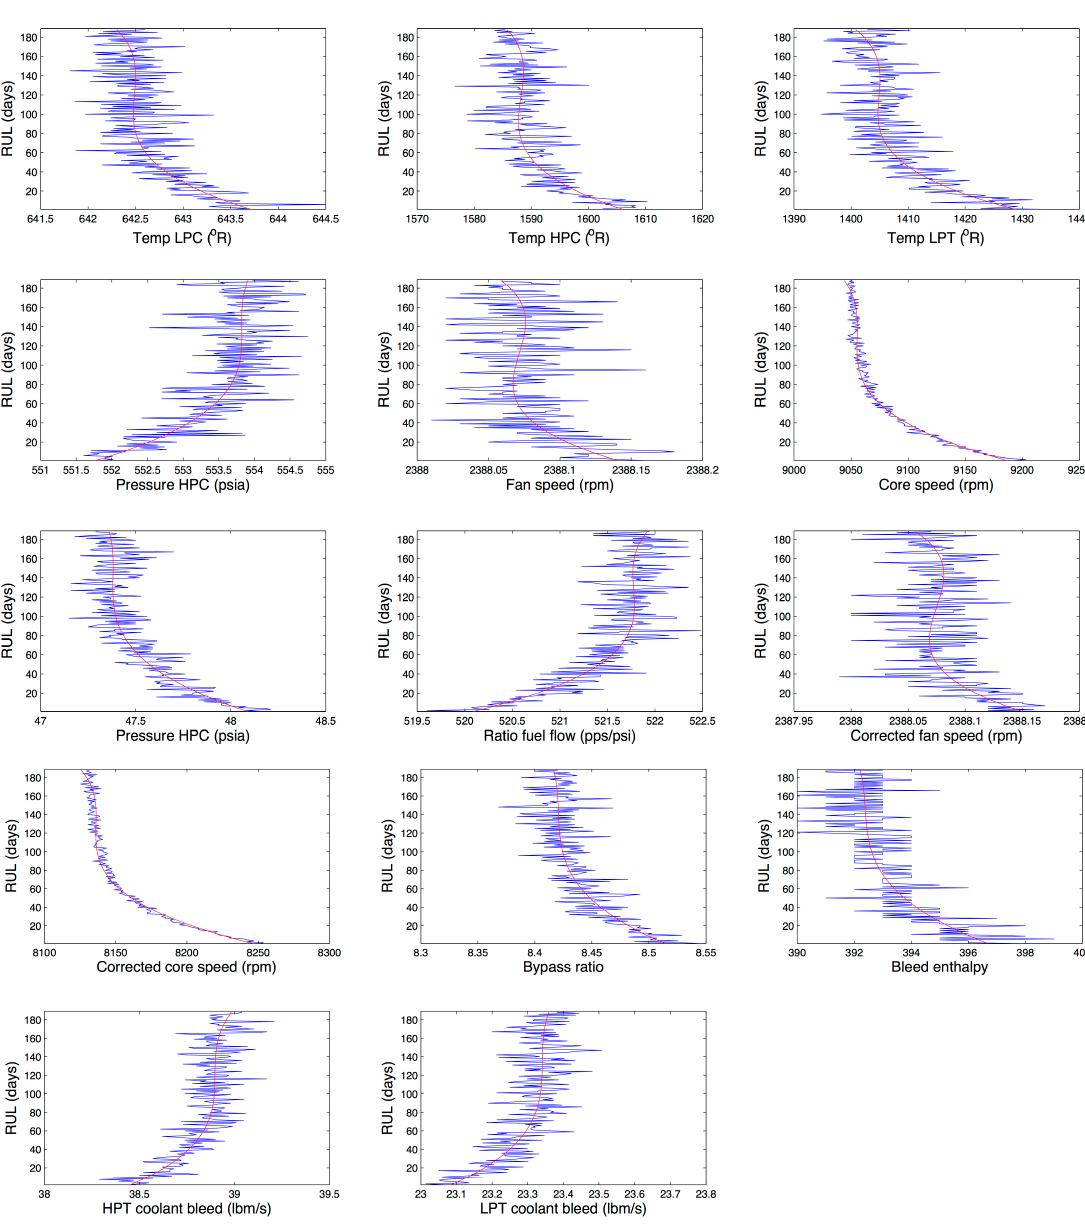
Figure 4. Independent variables vs. dependent variable (RUL) for turbine 4. This turbine contains 189 observations for each variable (red line represents the fitted third degree polynomial or cubic polynomial).